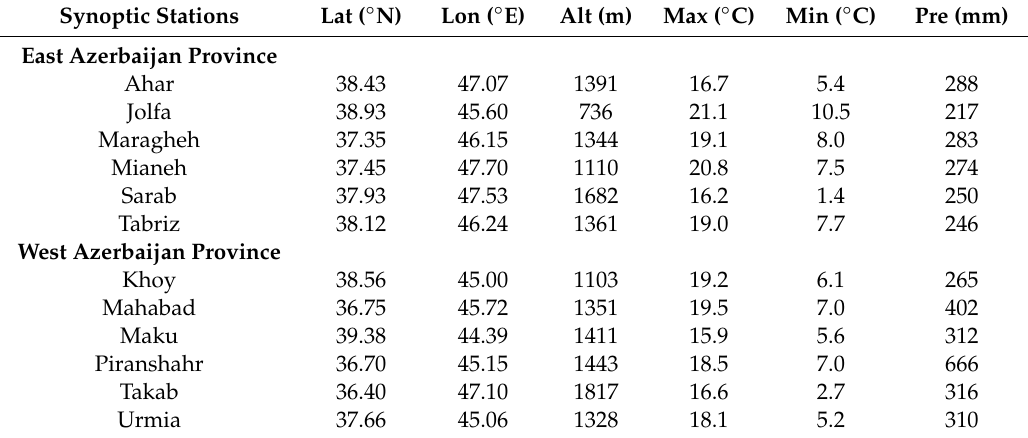
Figure 1. The geographical situation of the study area (West and East Azerbaijan provinces) along with the target counties. Table 1. Latitude (Lat), longitude (Lon), altitude (Alt), average annual maximum (Max) and average annual minimum temperatures (Min), and total annual precipitation (Pre) for the study sites during 1991–2016.